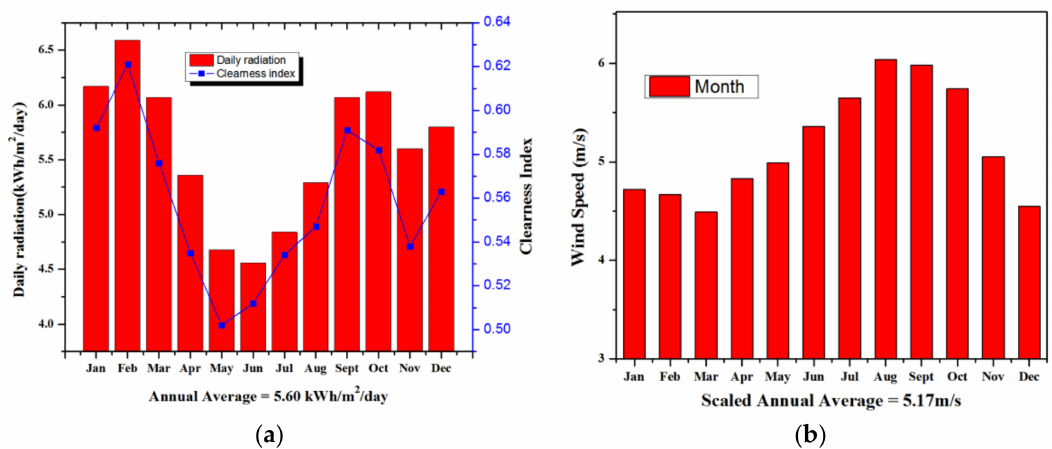
Figure 9. ( a ) Average Monthly solar Radiations with clearness index; and ( b ) Average Monthly wind speed (m/s) for Mbuguni